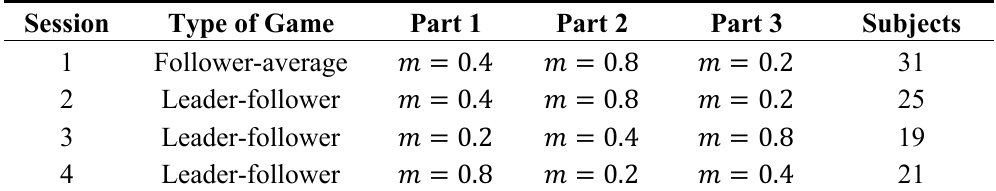
Table 1. Experimental